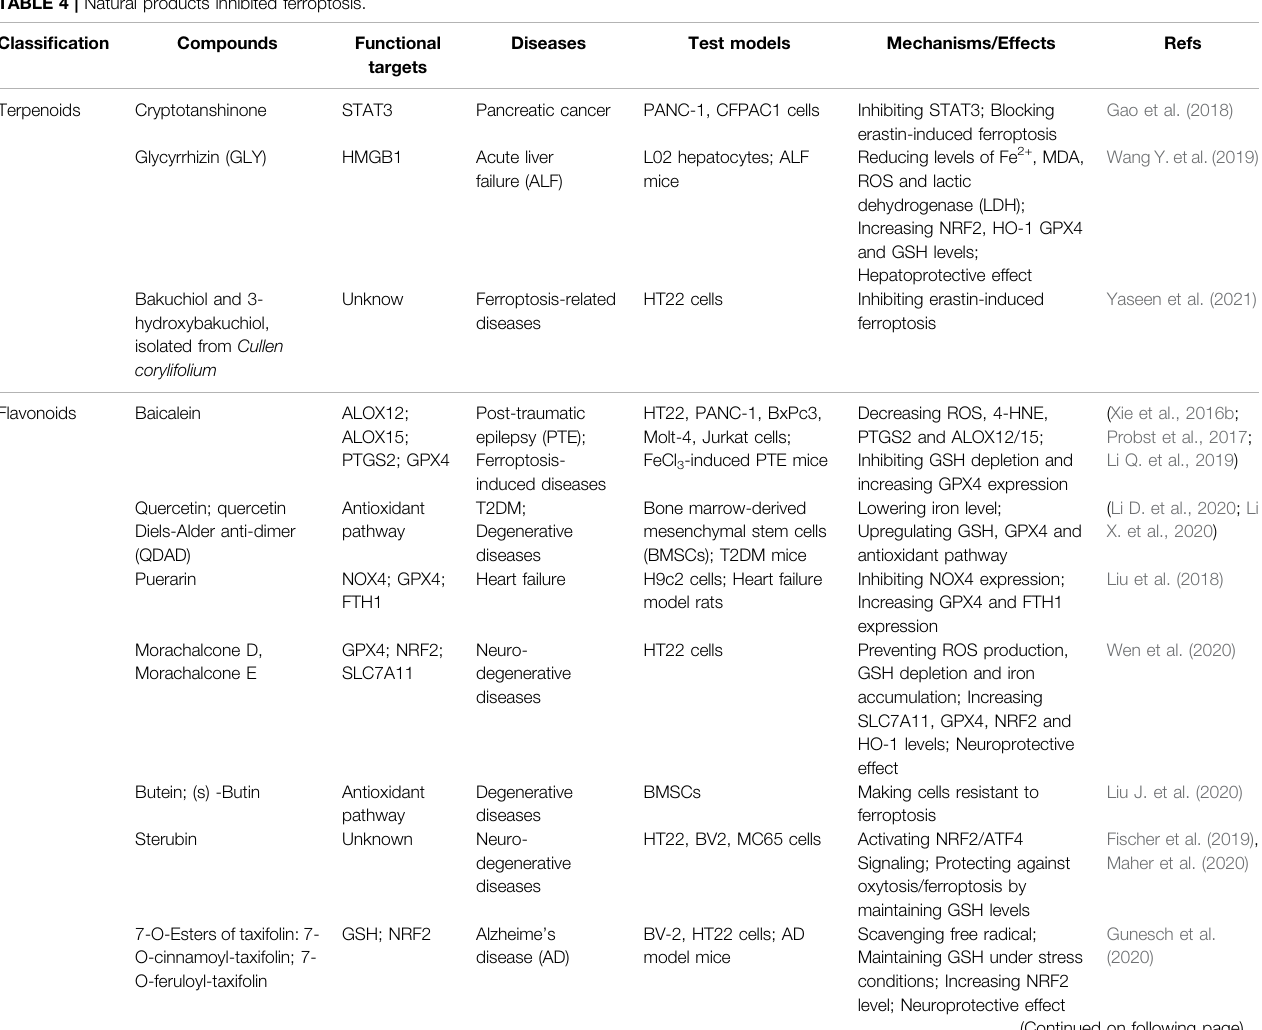
TABLE 4 | Natural products inhibited